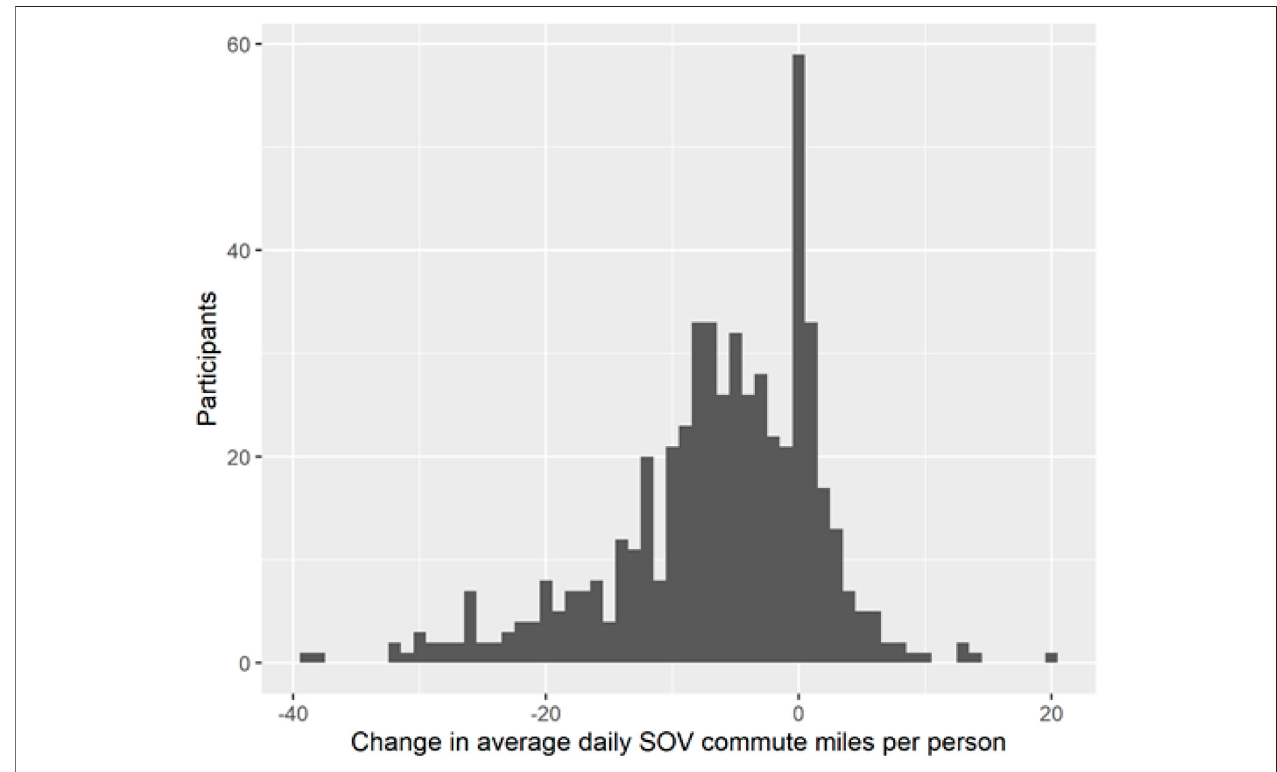
FIGURE 14 | Implied daily SOV miles changes (during — before) per person based on model predicted SOV rates and self-reported commute